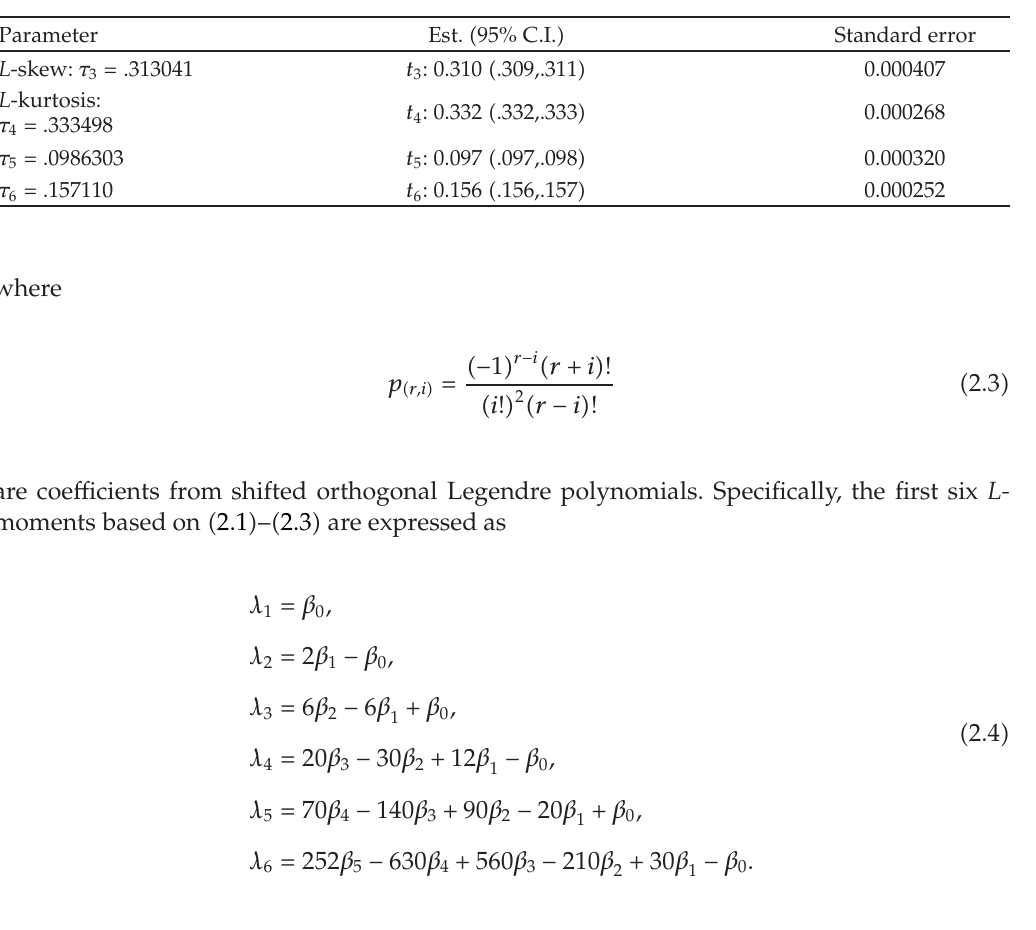
Table 2: L -moment ratios (cid:2) τ (cid:3) and their estimates (cid:2) t (cid:3) for the pdf in Figure 1. Each estimate and bootstrap confidence interval (cid:2) C.I. (cid:3) was based on resampling 25,000 statistics. Each sample statistic was based on a sample size of n (cid:7)